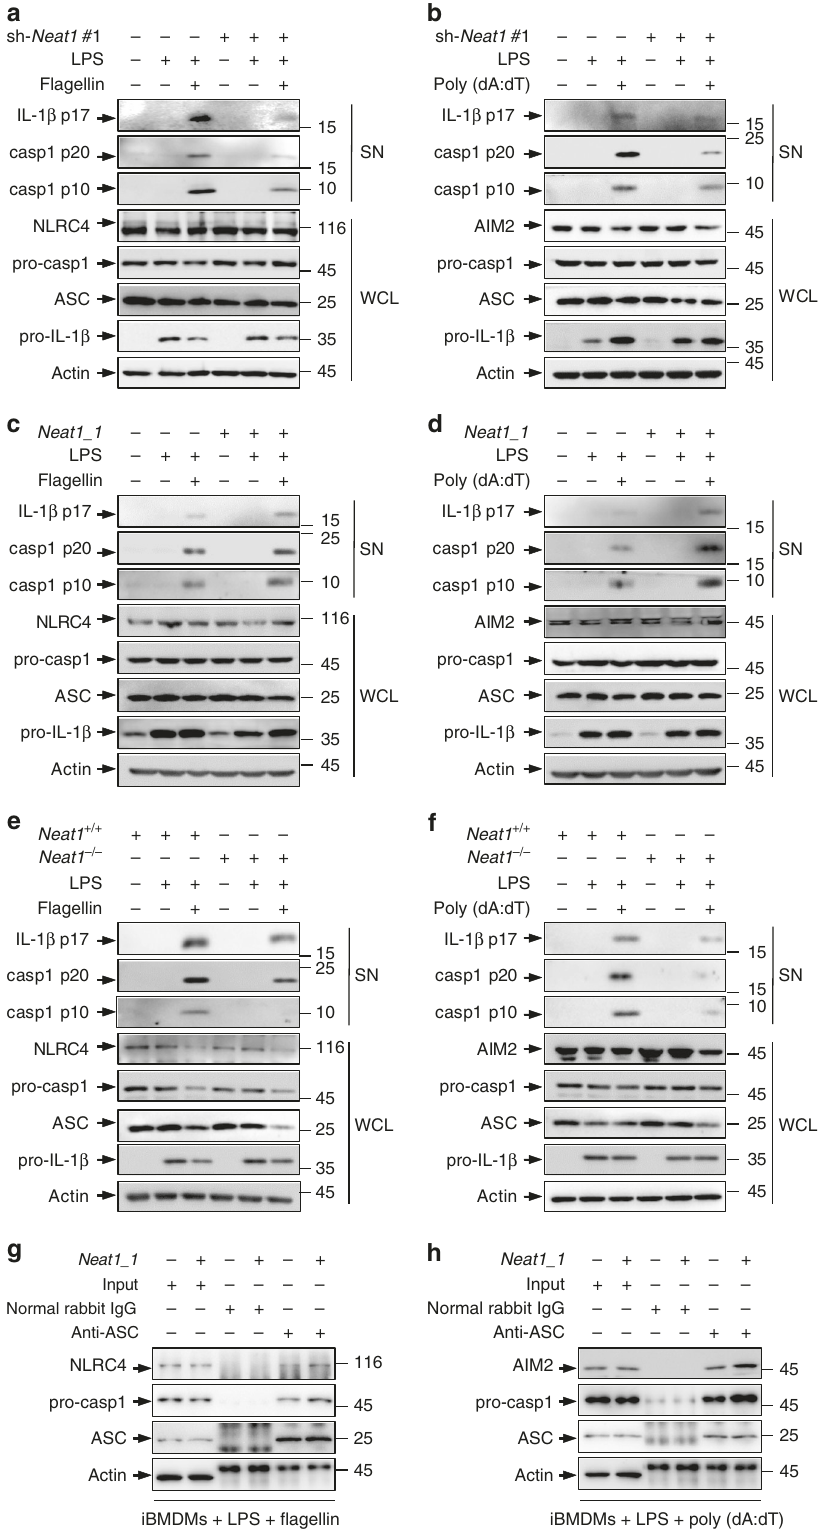
Fig. 2 Neat1 enhances the activation of NLRC4 and AIM2 in fl ammasomes. a – d iBMDMs devoid of Neat1 by shRNA #1 ( a , b ), iBMDMs overexpressing Neat1_1 ( c , d ), and the corresponding control iBMDMs were primed with LPS, and then stimulated with fl agellin ( a , c ) or poly(dA:dT) ( b , d ). WCL and SN were analyzed by western blotting. e , f BMDMs from Neat1 + / + or Neat1 − / − mice were primed with LPS and then stimulated with fl agellin ( e ) or poly(dA: dT) ( f ). WCL and SN were analyzed by western blotting. ( g , h ) Control iBMDMs and iBMDMs ectopically expressing Neat1_1 were primed with LPS and then stimulated with fl agellin ( g ) or poly(dA:dT) ( h ). Cell lysates were immunoprecipitated with normal rabbit IgG or ASC antibody. The samples were analyzed by western blotting as indicated. Source data are provided as a Source Data fi